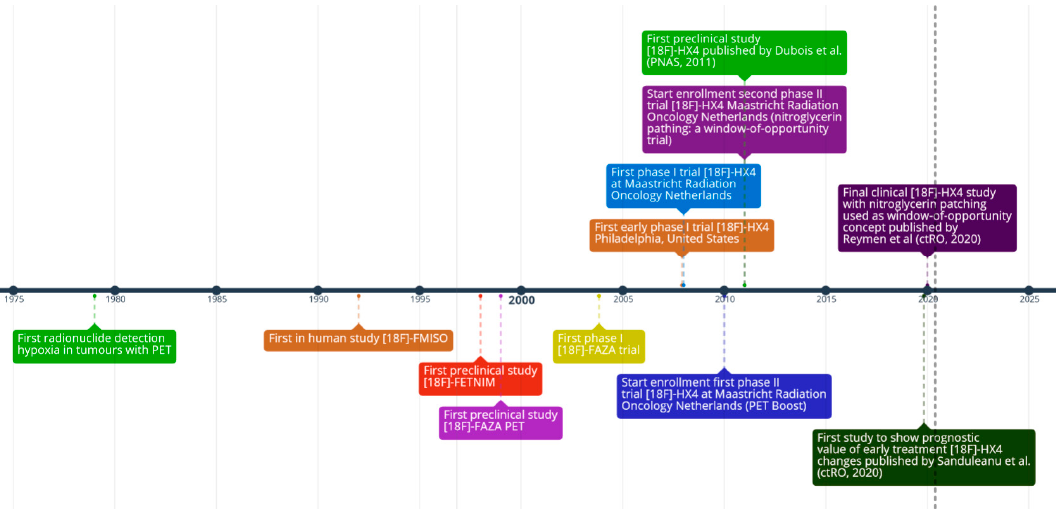
Figure 2. History of hypoxia PET, with a focus on the third generation PET tracer 18 F ‐ HX4.